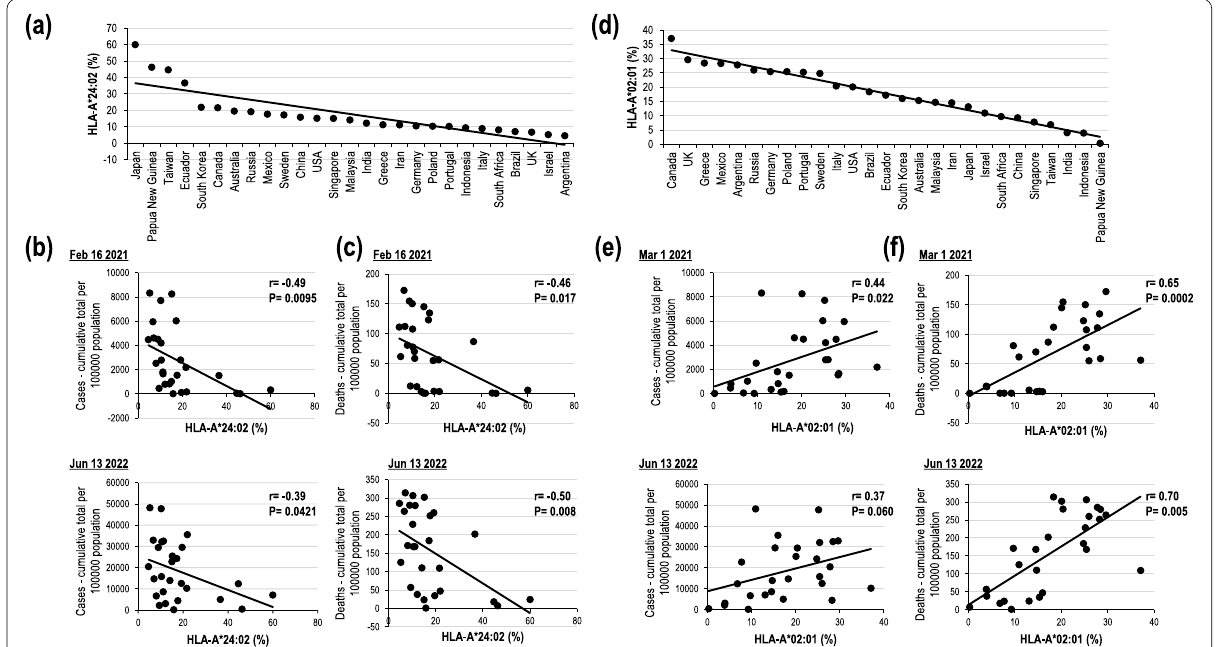
Fig. 1 Data on infection and death caused by SARS‑CoV‑2 in the HLA‑A*02:01‑ or HLA‑A*24:02‑positive population worldwide at two time points. ( a ) Data on the HLA‑A*24:02‑positive population in the indicated countries, which is derived from the Allelic Frequency Net Database (AFND, http:// www. allel efreq uenci es. net/) [54]. ( b , c )Correlation between HLA‑ A*24:02 and ( b ) COVID‑19 cases [cumulative total per 10 5 population] and ( c